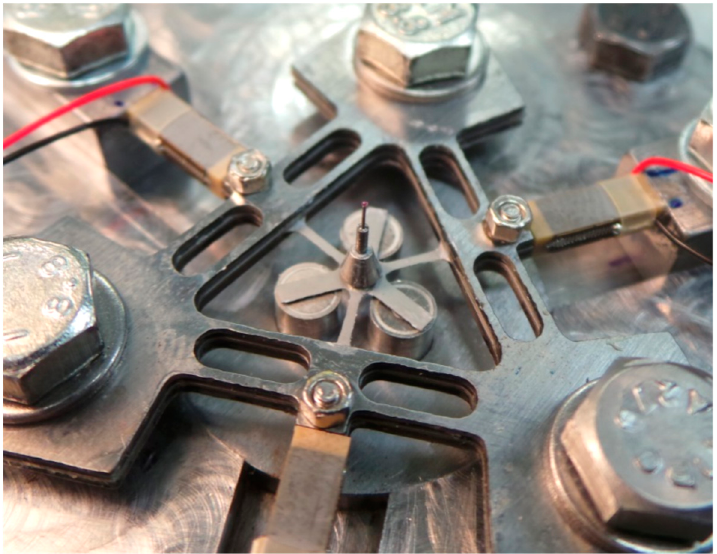
Figure 2. Assembled probing system, with stylus length 5.6 mm and 300 µm diameter ruby tip.